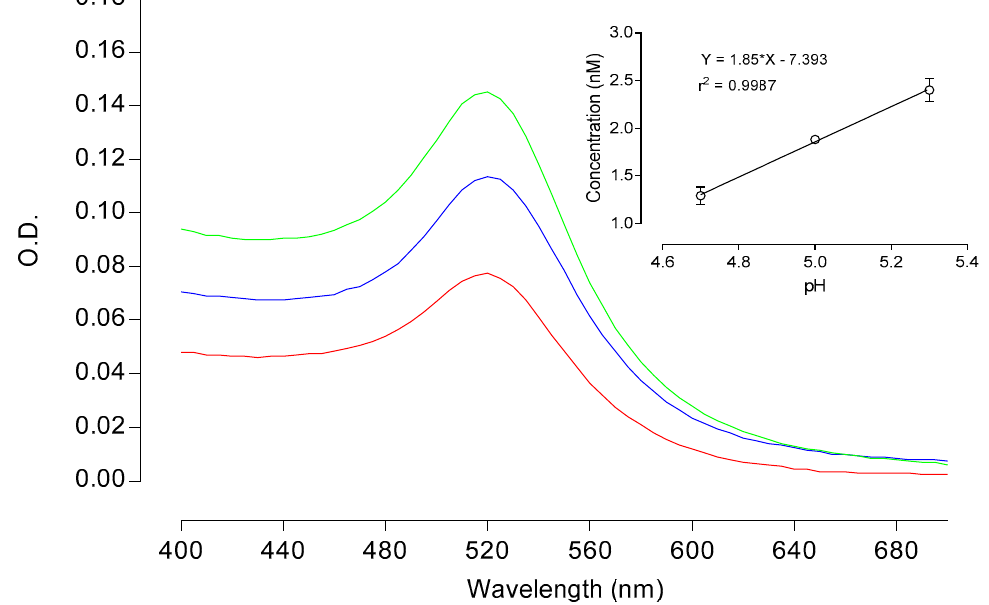
Figure 2. Absorption spectra of gold nanoparticles (AuNPs) obtained by the citrate reduction method at pH 4.7 (red line), 5.0 (blue line), and 5.3 (green line). The inset shows the linear correlation curve between pH and AuNP concentration is presented. Optical densities (O.Ds) correspond to the mean values calculated from independent determinations ( n = 2).